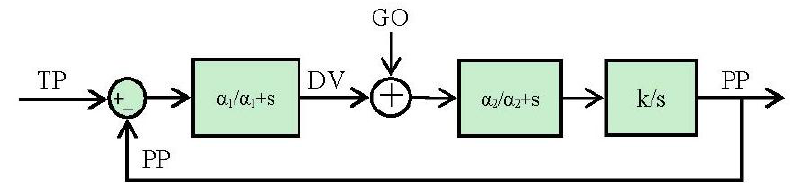
Figure 9. Block diagram for the VITE algorithm in the spike-based paradigm. We have included the low pass filter for the ramp